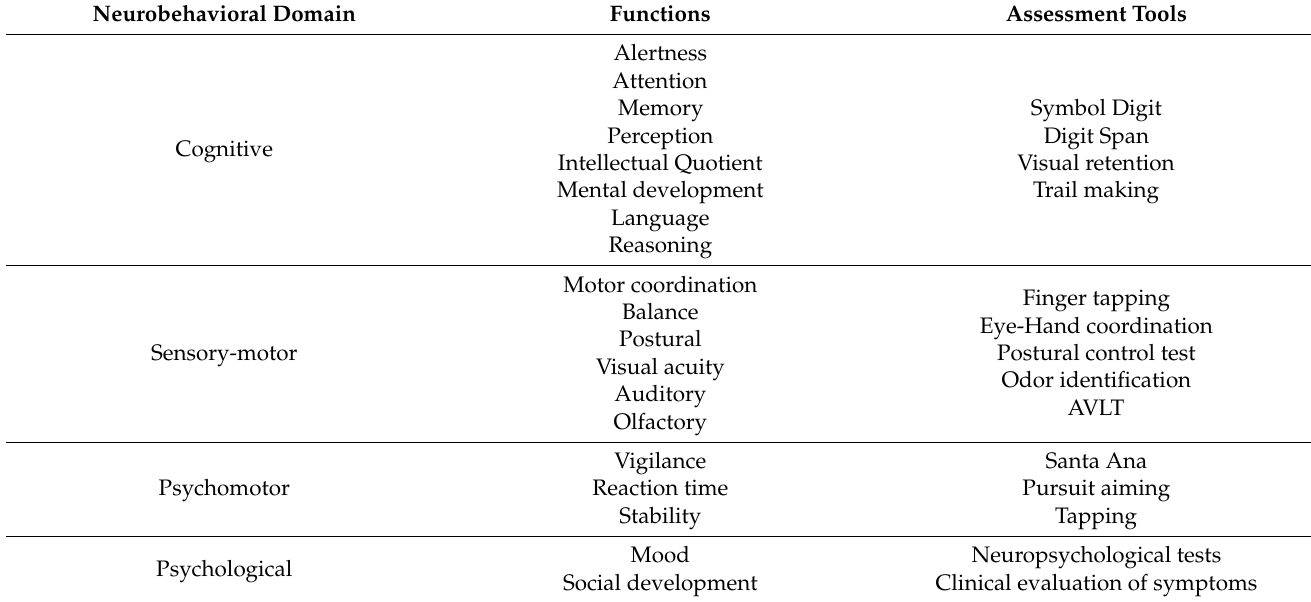
Table 1. Neurobehavioral domains, their functions, and an example of assessment tools. Neurobehavioral Domain Functions Assessment